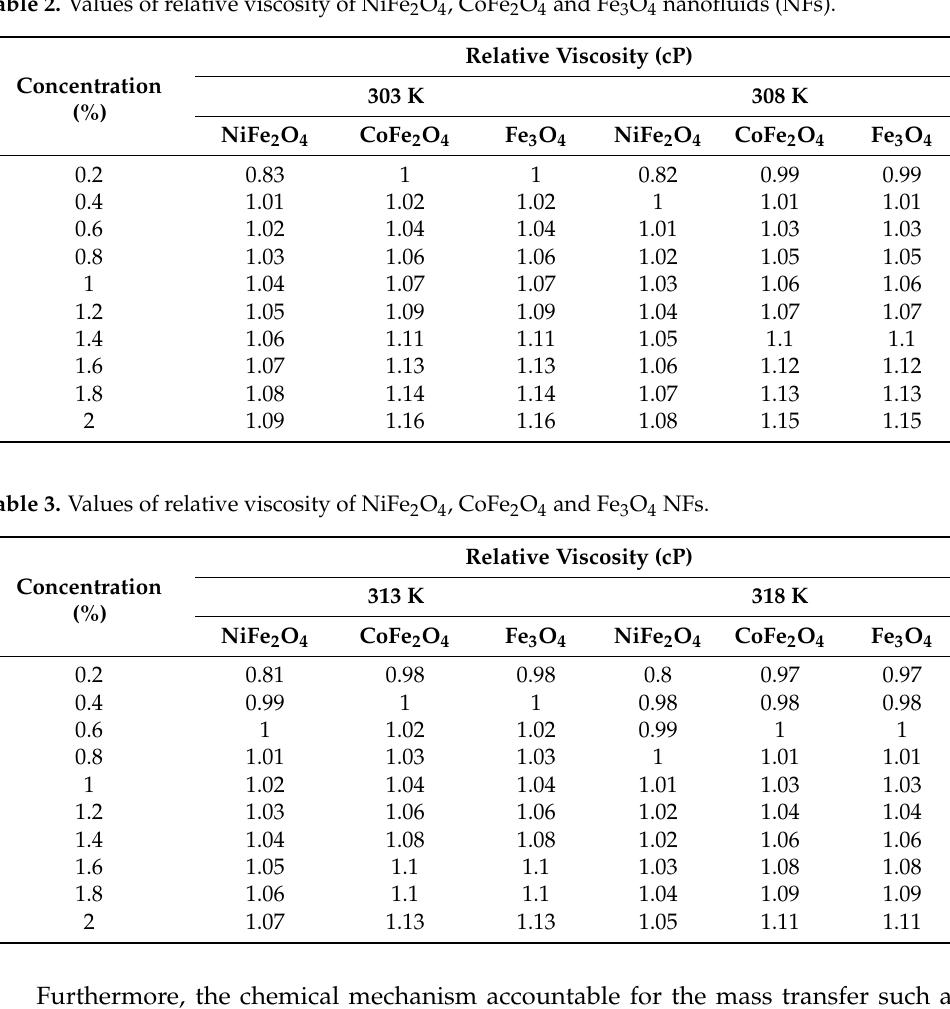
Table 2. Values of relative viscosity of NiFe 2 O 4 , CoFe 2 O 4 and Fe 3 O 4 nanofluids (NFs).